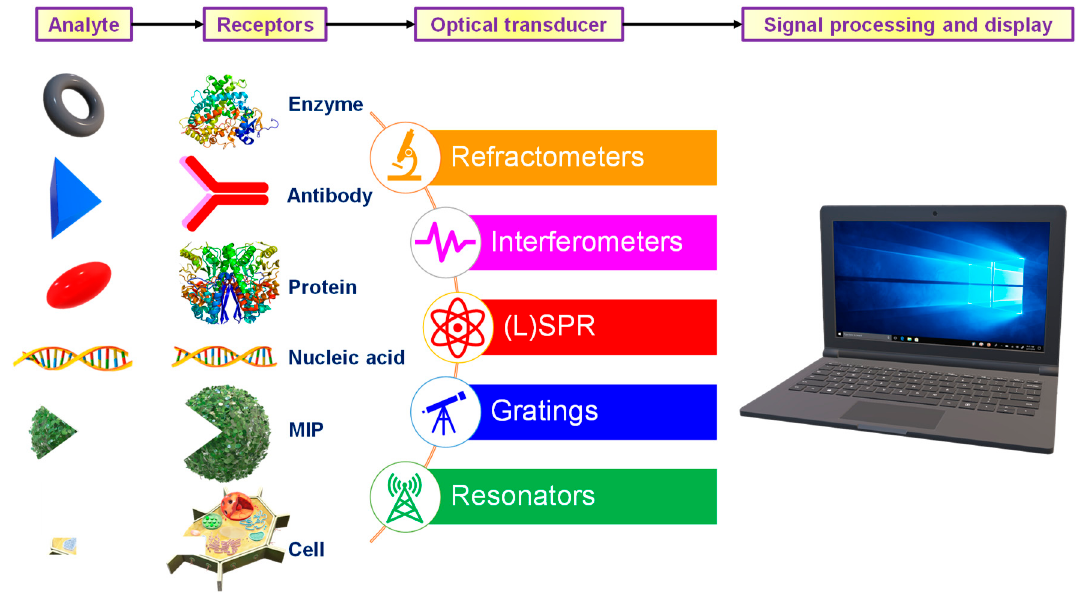
Figure 2. Construction of different optical sensors.